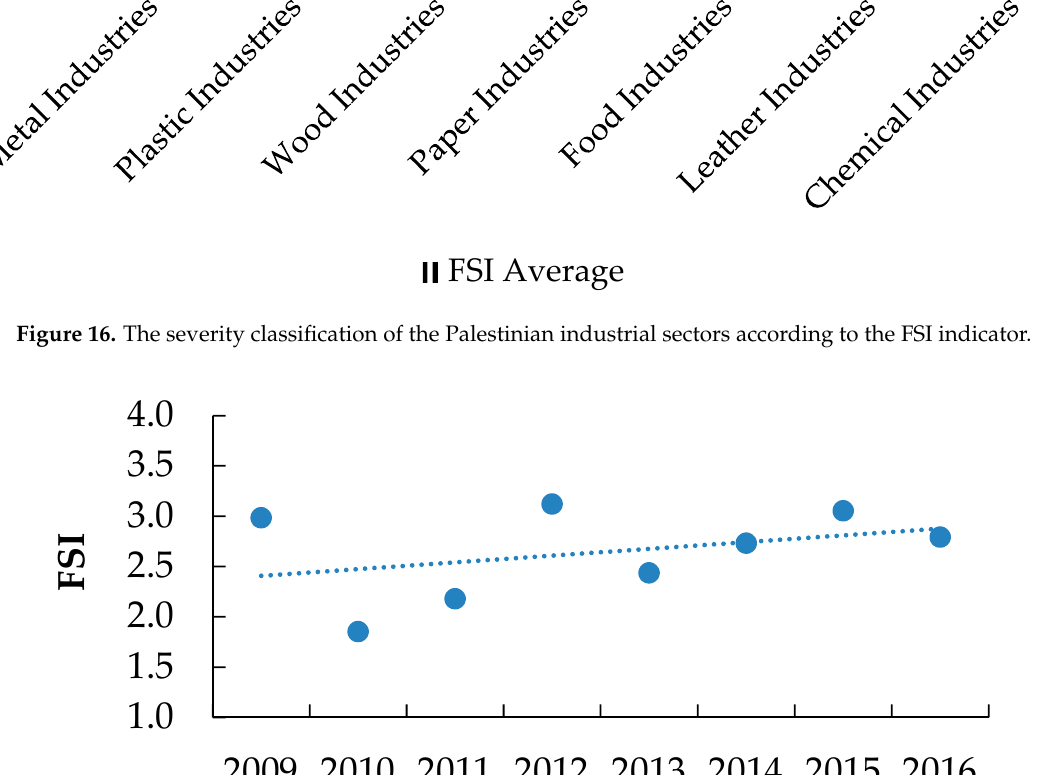
Figure 18. The SPF indicators for the Palestinian industrial sector between the years 2009 and 2016, where SPF = Number of working hours/days lost due to each occupational accident, regard- less of its severity. Figure 19 classifies the Palestinian industrial sectors according to their seriousness, starting with the sector with the highest SPF and ending with the lowest SPF. The figure also shows the classification variations once FSI is used as a comparison indicator.